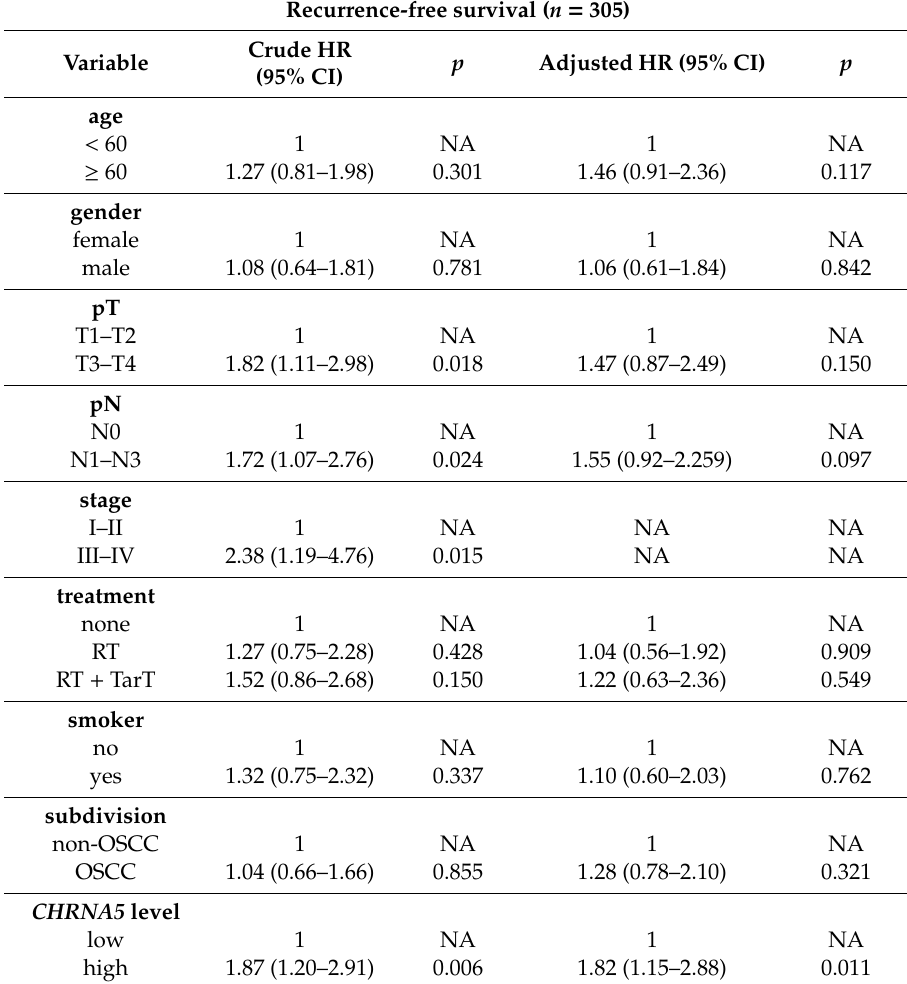
Table 1. Cox univariate and multivariate analyses of recurrence-free survival probability in association with CHRNA5 mRNA expression levels and pathological stage in a TCGA cohort with head and neck cancers. The abbreviations OSCC, pT, pN, RT and TarT stand for oral squamous cell carcinoma, pathologic T stage, pathologic N stage, radiation theray and targeted therapy, respectively.